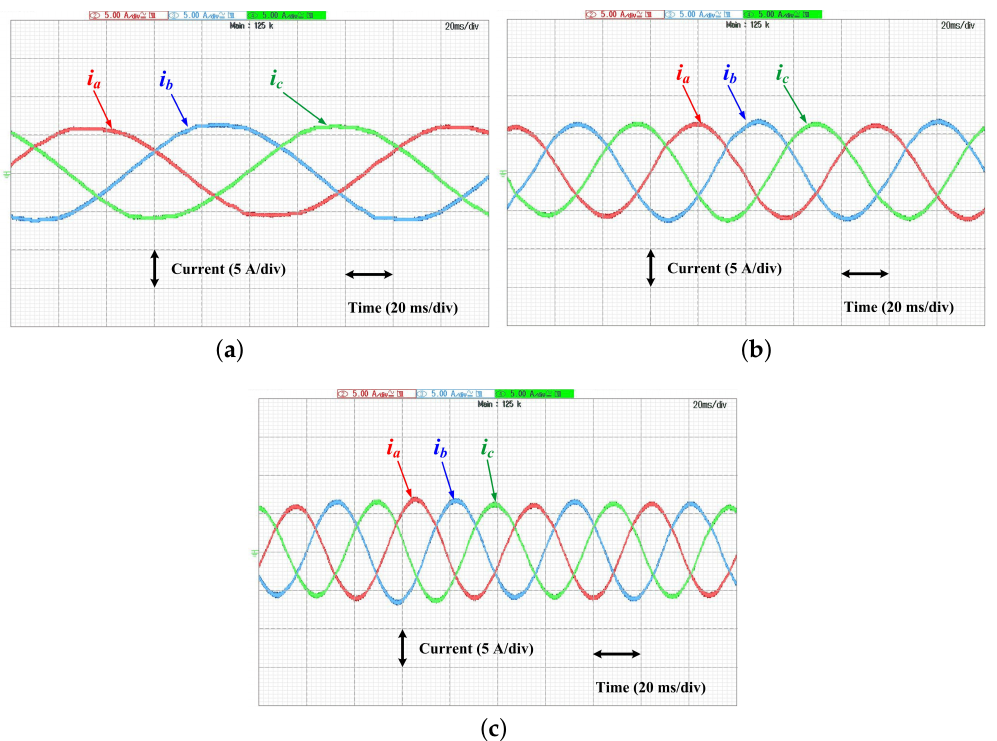
Figure 17. Actual three-phase currents at different motor speeds; time scale: 20 ms/div. ( a ) 100 r/min; ( b ) 200 r/min; and ( c ) 300